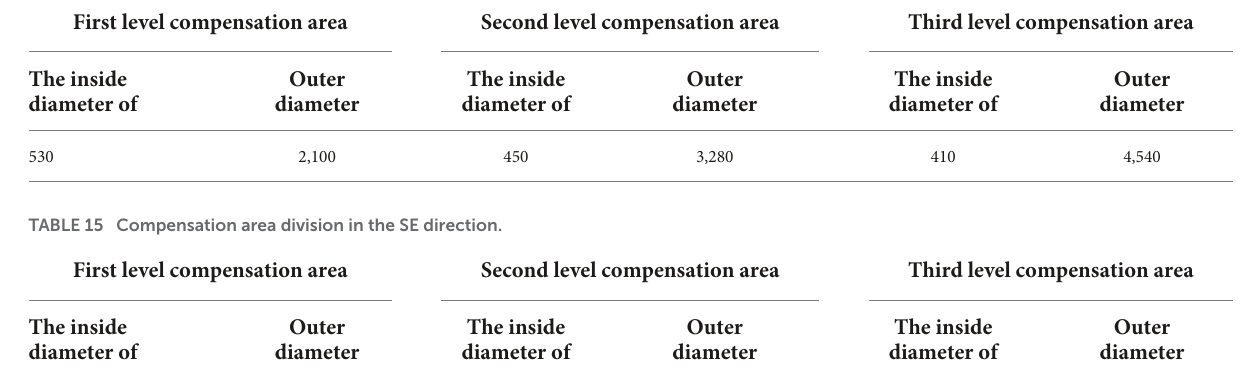
TABLE 14 Division of compensation area in E direction.